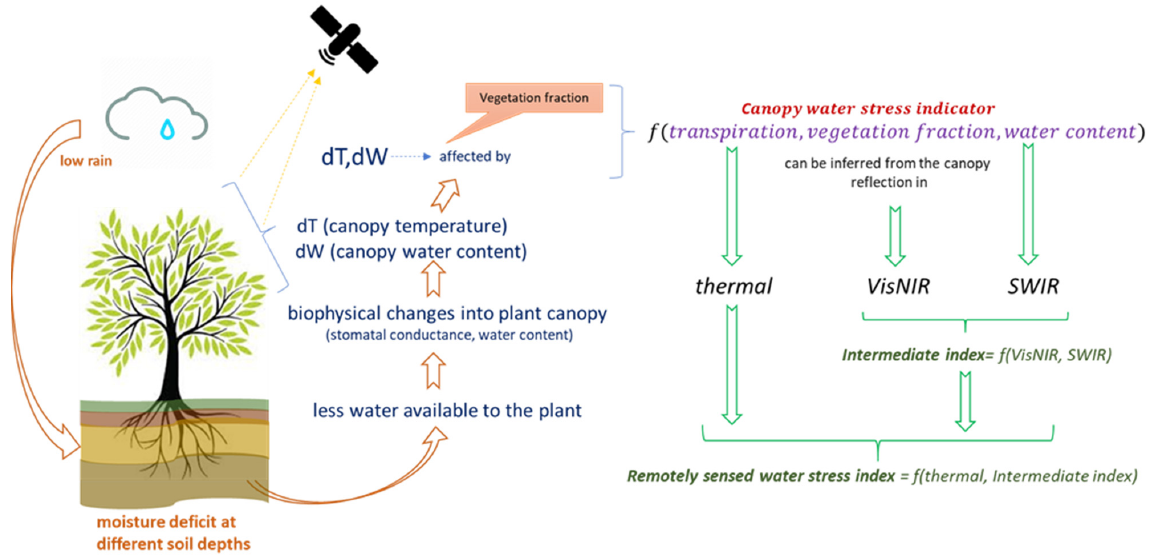
Figure 3. Conceptual model and the idea behind the development of the proposed remotely sensed water stress index. dT: change in canopy temperature, dW: change in canopy water content, VisNIR: Visible and Near Infrared (NIR), SWIR: Short Wave Infrared.